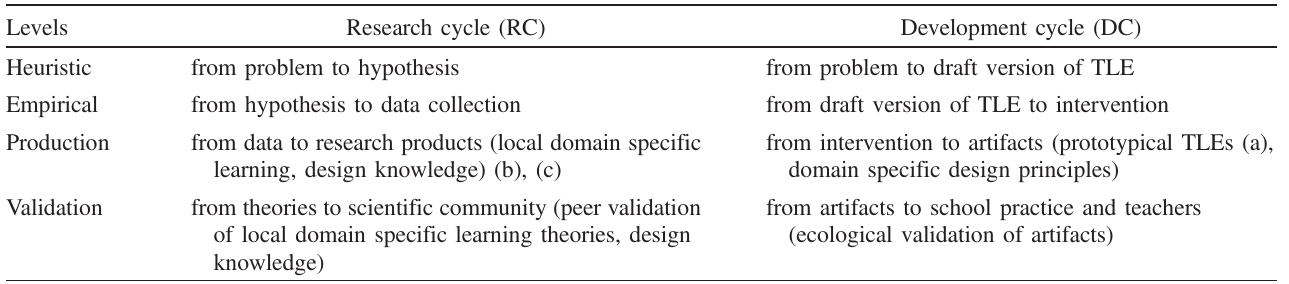
TABLE I. Levels and process steps in the research and development cycle of design-based research. (a), (b) and (c) indicate the main objectives of our DBR